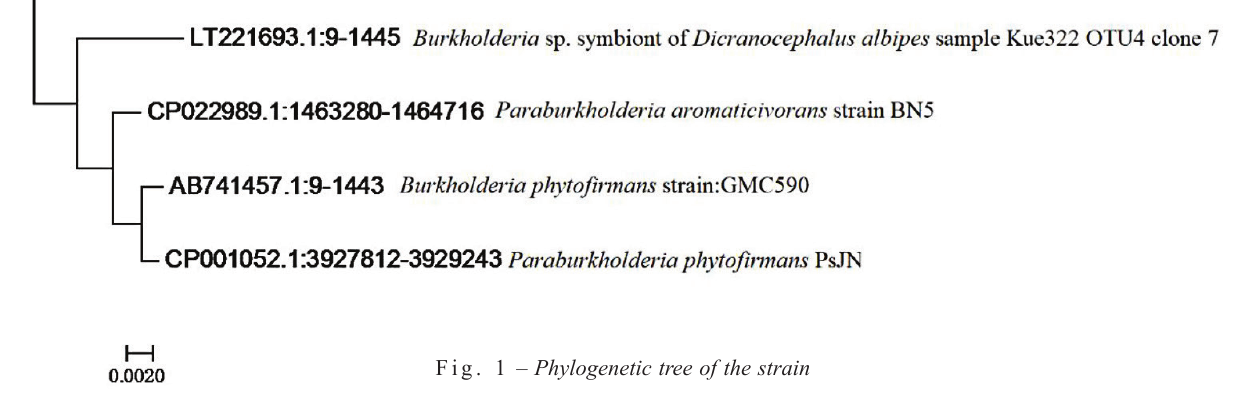
Fig. 1 – Phylogenetic tree of the